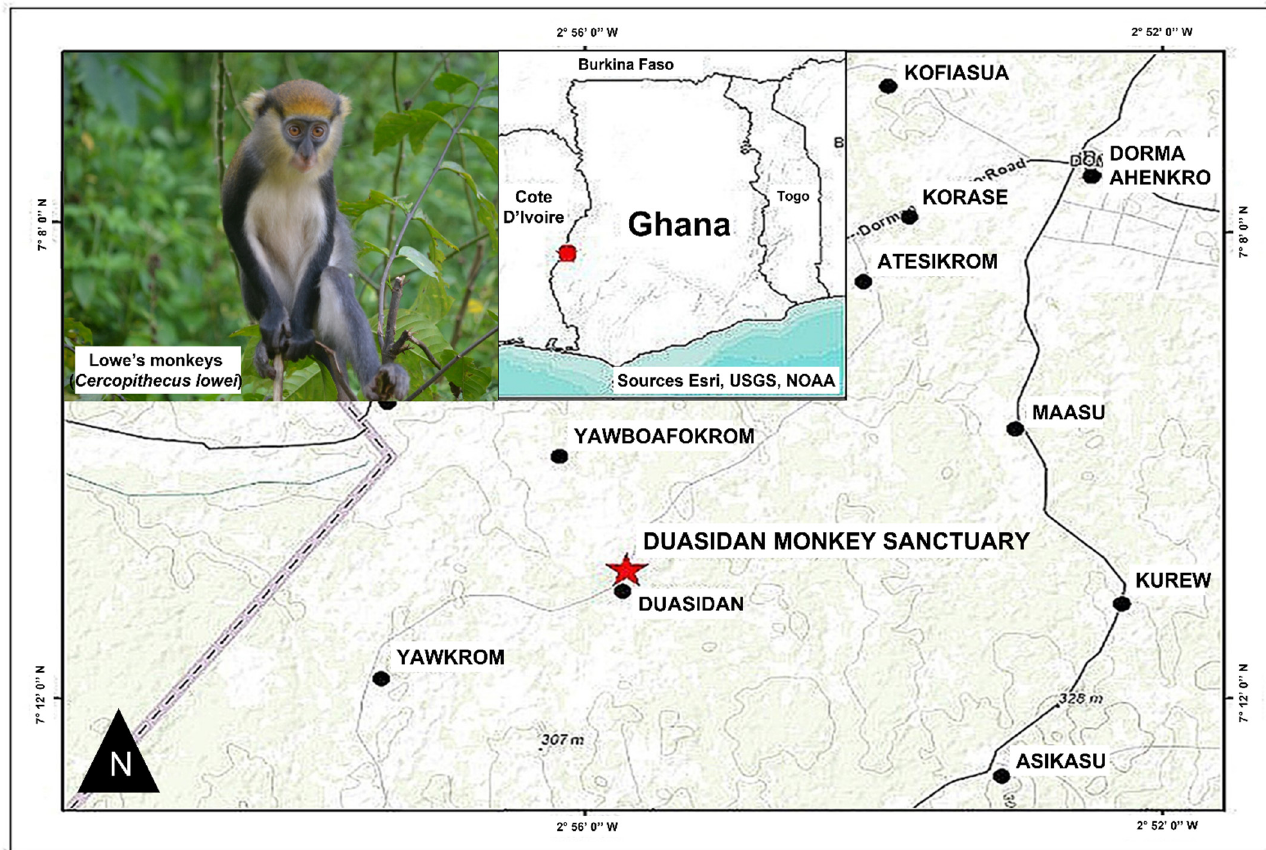
Figure 1. Location map of the study site, Duasidan Monkey Sanctuary (red star), Ghana and the study species, Lowe’s monkeys ( Cercopithecus lowei ). Sources for the map: Esri, USGS, FAO, NPS, OpenStreetMap Contributors, and the GIS User community. Photo credit: Edward Debrah Wiafe.